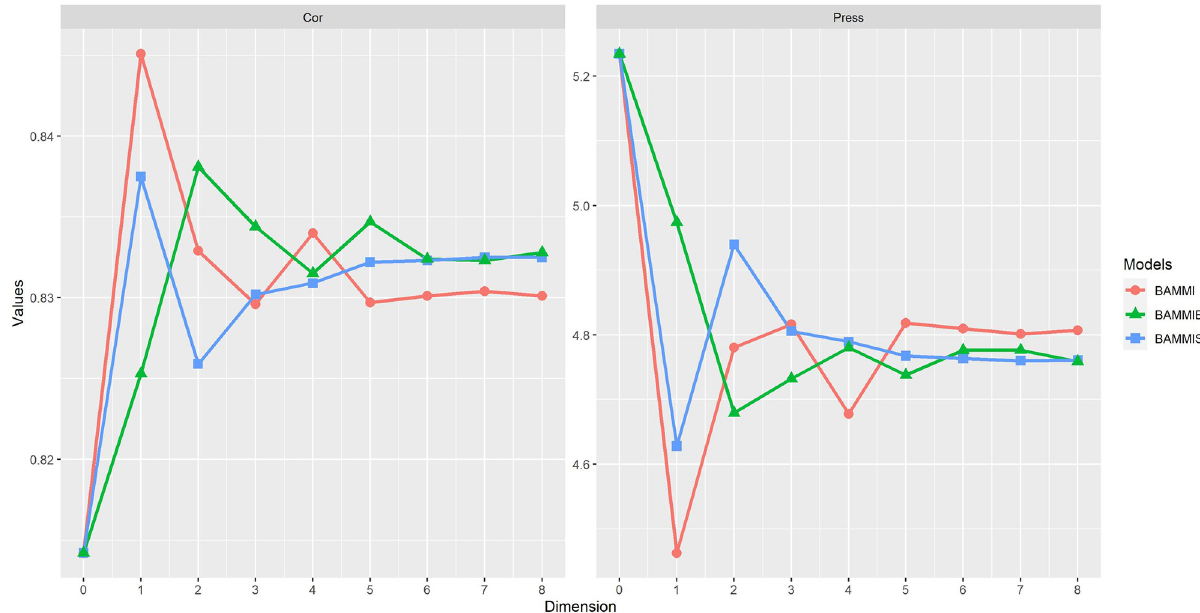
Fig 8. Ockham’s plot for the mean evaluation of the predictive capacity of the models based on the criteria of correlation between the observed and estimated values and the PRESS (Gibbs algorithm).